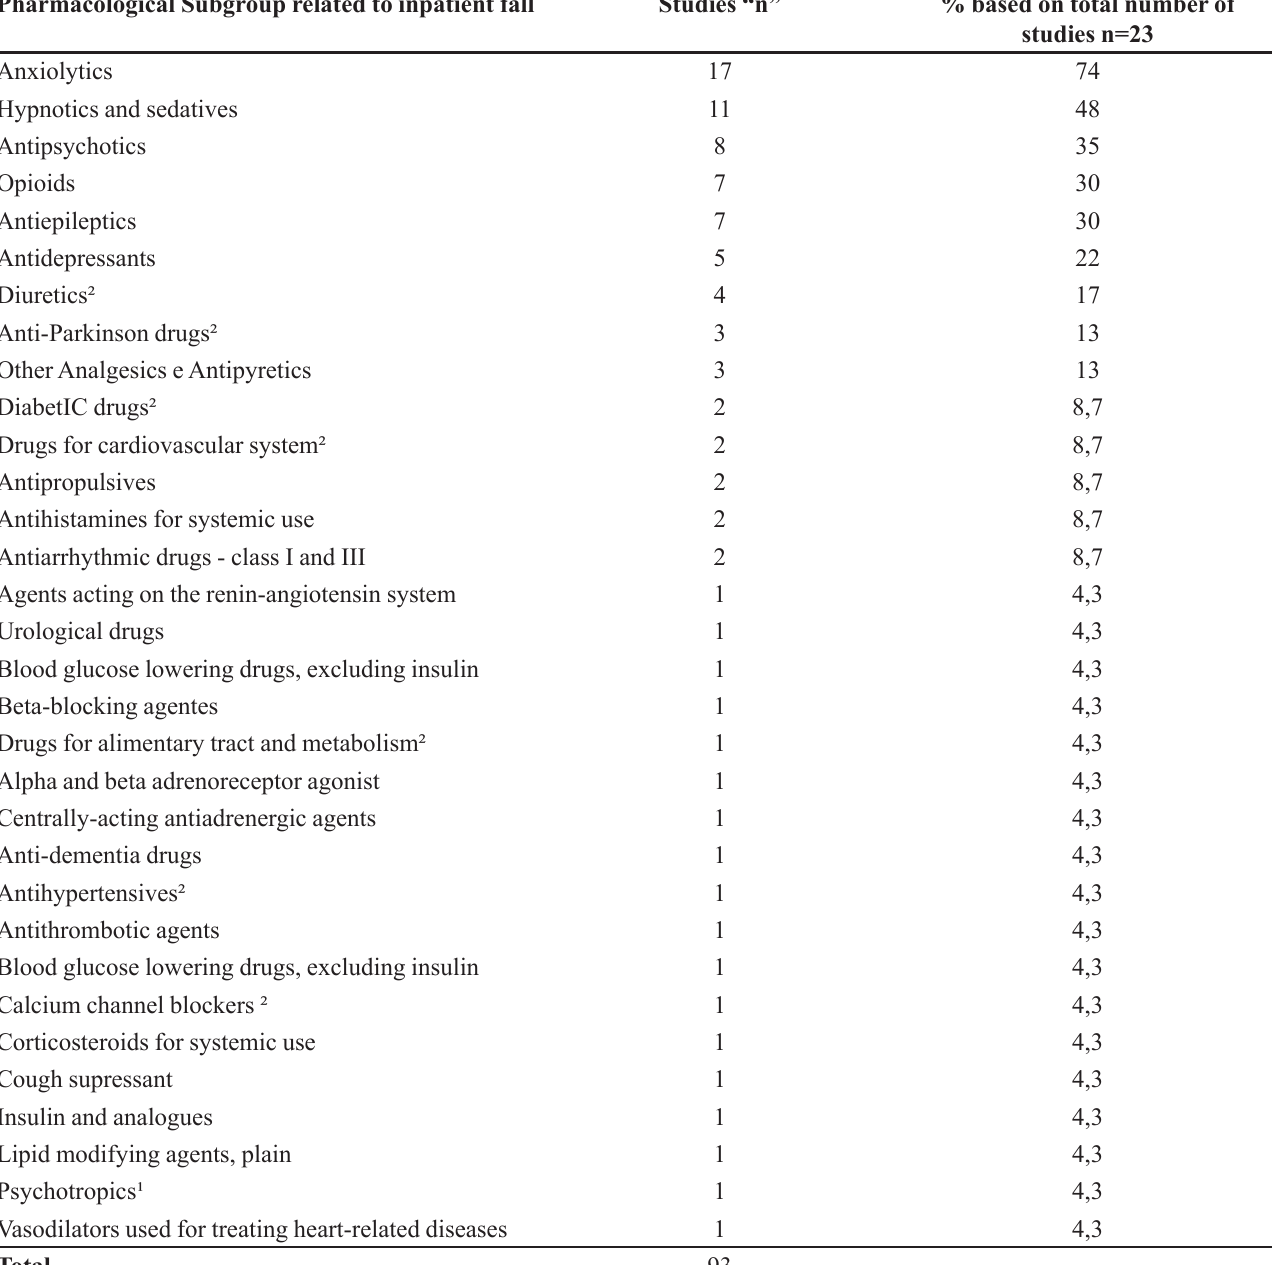
TABLE IV - Distribution of pharmacological subgroups according to ATC classification for medications related to inpatient falls Pharmacological Subgroup related to inpatient